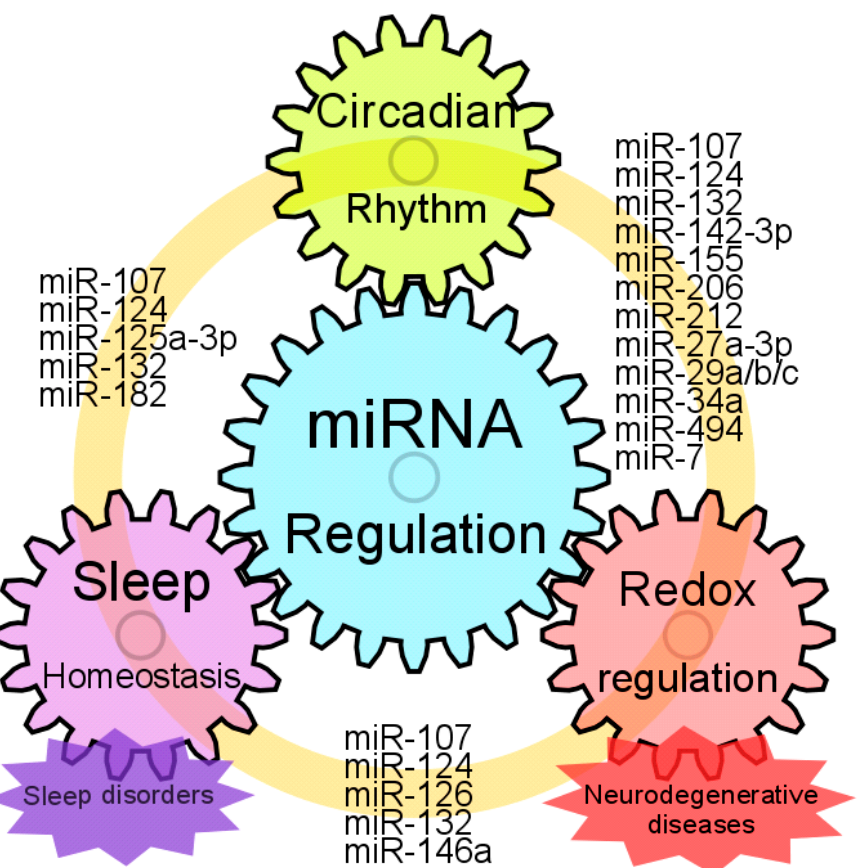
Figure 2. Models for interplay of miRNA regulation, circadian rhythm, sleep homeostasis and neuroprotection. Common miRNAs which could regulate circadian rhythm, sleep homeostasis and redox states are represented. Sleep homeostasis is strongly connected to circadian rhythm. Disruption of circadian rhythm causes sleep disorder, and vice versa. Patients with neurodegenerative disease often complain of sleep deprivation. Moreover, sleep disorders can be an early symptom of neurodegenerative diseases. Several miRNAs that are altered with the circadian abnormalities, sleep disorders or neurodegenerative diseases are dysregulated in the brain and blood of disease-model animals or patients with neurodegenerative diseases. Taken together, these facts suggest that miRNAs have the potential to be biomarkers as well as therapeutics for these diseases.